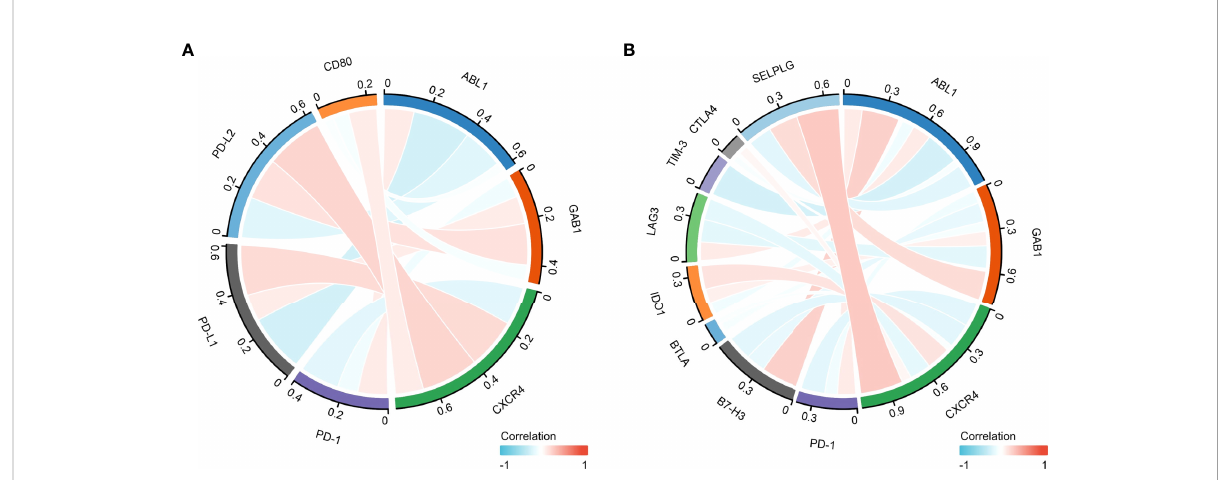
FIGURE 8 The correlation between the immune hub genes and immune checkpoint genes. (A) The correlation between the immune hub genes (ABL1, GAB1, and CXCR4) and the Programmed cell Death 1 (PD-1), Programmed cell Death Ligand 1 (PD-L1) pathway. (B) The correlation between the immune hub genes and the other immune checkpoint molecules. Programmed cell Death 1 (PD-1), Programmed cell Death Ligand 1 (PD-L1), Programmed cell Death Ligand 2 (PD-L2), Cluster of Differentiation 80 (CD80), P-selectin glycoprotein ligand-1 (SELPLG), Cytotoxic-T- Lymphocyte-Antigen-4 (CTLA4), T cell immunoglobulin and mucin domain 3(TIM-3), lymphocyte activation gene-3 (LAG3), B- and T- lymphocyte attenuator (BTLA), B7 homolog 3 protein (B7-H3), Indoleamine 2,3-dioxygenase 1 (IDO1), Abelson 1 (ABL1), GRB2-associated binding protein 1 (GAB1), CXC motif chemokine receptor type